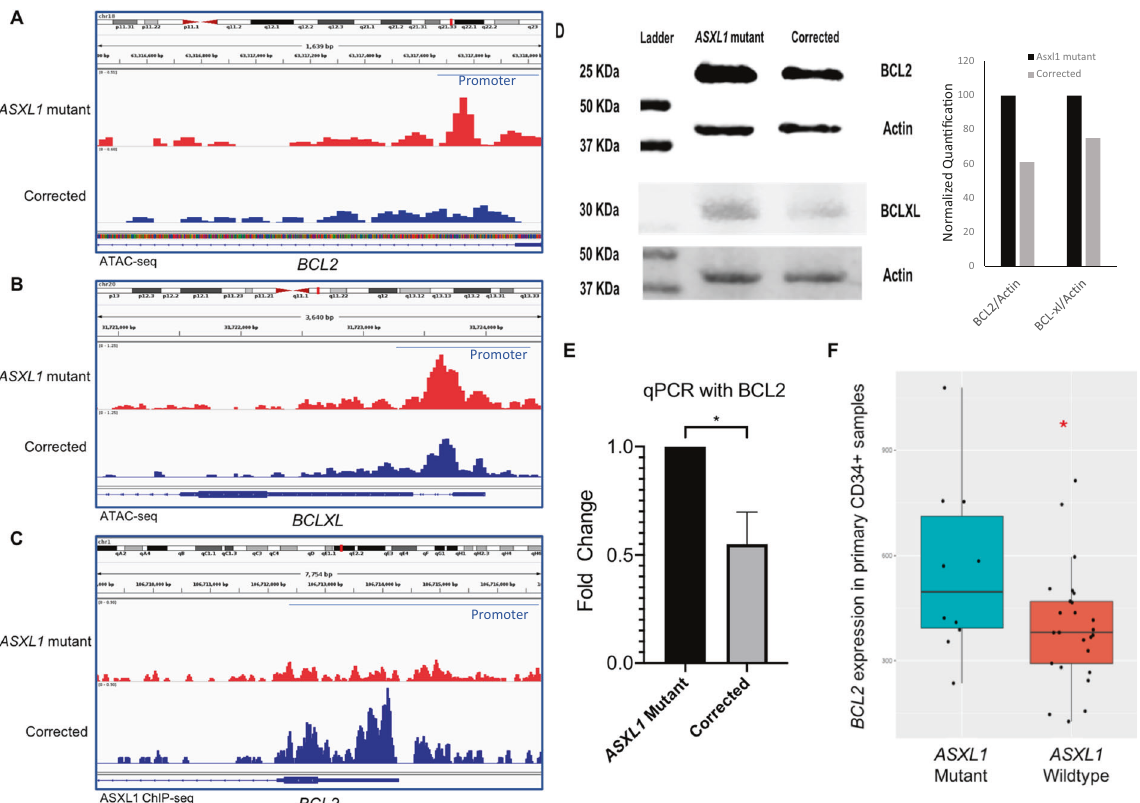
Fig. 2 ASXL1 mutation leads to increased chromatin accessibility and increased expression of BCL2 . A , B ATAC-sequencing demonstrates increased chromatin accessibility in the promoter regions of anti-apoptotic genes BCL2 and BCLXL in the mutant ASXL1 cells compared to the homozygous corrected cells. C ChIP-sequencing from a mouse model of ASXL1 mutant knock-in mice demonstrates wild-type ASXL1 to be present at the BCL2 promoter region with no binding of the ASXL1 mutant seen at this locus. D Immunoblotting shows increased protein levels of BCL2 and BCLXL in ASXL1 mutant cells. The normalized intensity of BCL2/actin is shown as bar graphs. E qRT-PCR demonstrates increased expression of BCL2 in ASXL1 mutant cells. F Gene expression analysis of the anti-apoptotic gene BCL2 in the ASXL1 mutant and wild-type primary CD34 + patient MDS samples demonstrates signi fi cantly higher expression of BCL2 in the mutant samples compared to the wild-type Annexin V Alexa Fluor 488 (Thermo Fisher Scienti fi c, Cat No. A13199) and Propidium iodide, and fl ow cytometry was conducted using a BD FACS LSRII instrument to evaluate the percentage of viable cells, the percentage of cells in early and late apoptosis, and cells undergoing apoptosis. Data were analyzed using FlowJo. DNA extraction Genomic DNA was extracted from the ASXL1 mutant and corrected KBM5 cells using the Blood & Cell Culture DNA Mini Kit (Qiagen, Germantown, MD, USA, Cat No./ID: 13323), following the manufacturer ’ s protocol. RNA-sequencing Total RNA was isolated from the ASXL1 mutant and the corrected KBM5 cells using the Qiagen RNeasy Mini Kit (Cat No./ID: 74104) and the integrity of the total RNASeq libraries were multiplexed and sequenced as 1×150bp single end on NEXTSEQ 500 (Illumina, San Diego, CA, USA) following standard protocols. Sequencing data was QC and analyzed using GSNAP (http:// research-pub.gene.com/gmap/) software for mapping to a reference genome and HTSeq-count (http://www-huber.embl.de/users/anders/HTSeq/) to assign unique counts to ENSEMBL annotated transcripts. The Bioconductor package DESeq (http://bioconductor.org) was used to determine the relative counts of sequences from each gene relative to each other (transcriptional pro fi ling) and for normalization and statistical comparison. ATAC-sequencing A suspension of 50 000 cells from both the ASXL1 mutant and the corrected KBM5 cells were harvested, resuspended in cold ATAC-seq resuspension buffer (RSB), and subjected to Omni-ATAC-seq [14]. ATAC-Seq libraries were QC and multiplexed for sequencing as 2 × 75bp paired-end on NEXTSEQ